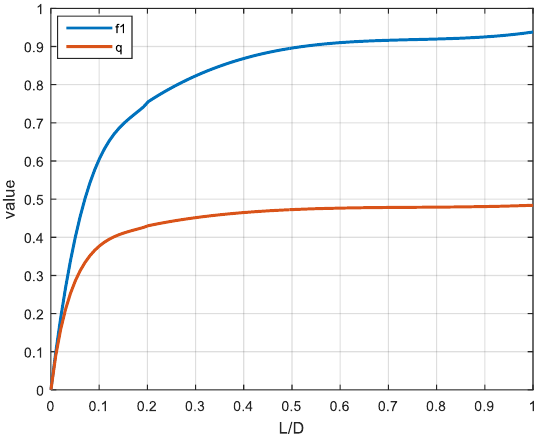
Figure 3. Tension factor fitting curve.